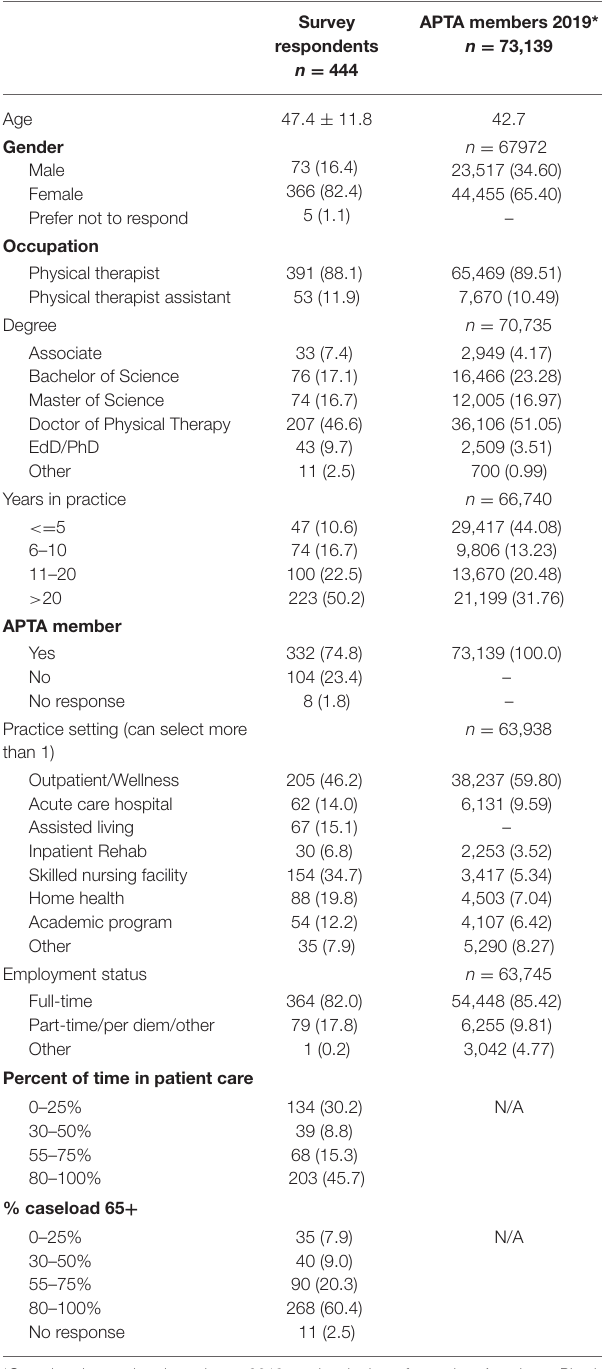
TABLE 1 | Demographics of survey respondents and American Physical Therapy Association (APTA) members: mean ± standard deviation or n